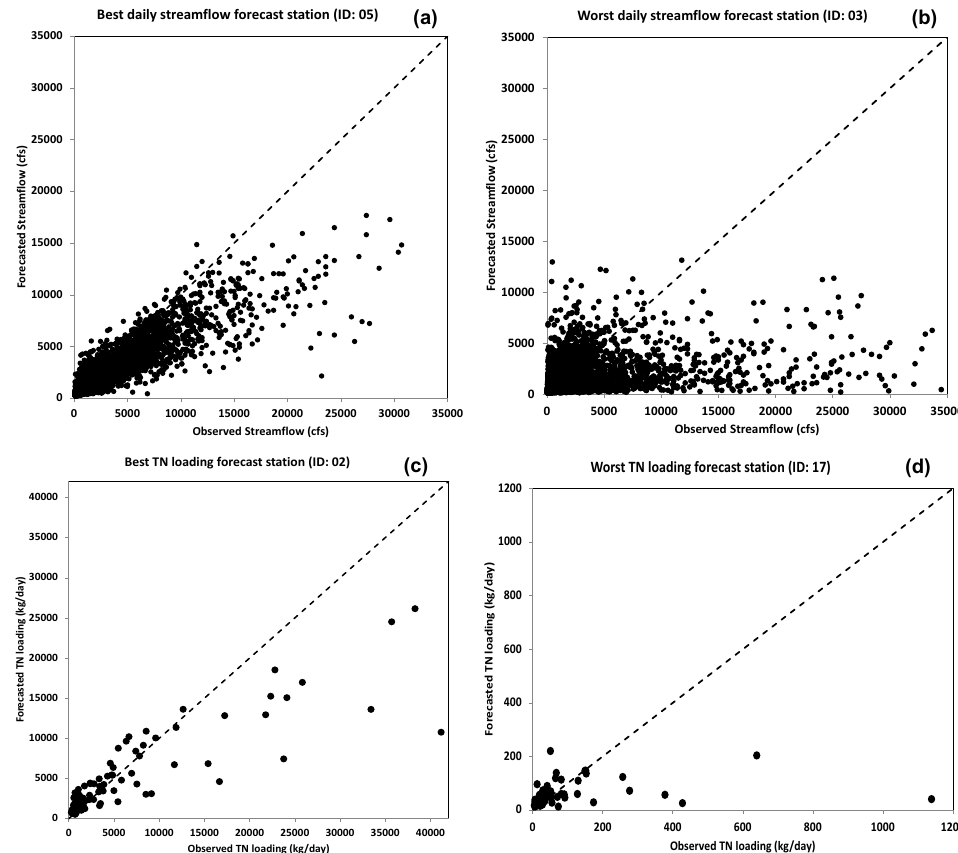
Figure 7. Comparison of observations and forecasts of streamflow ( a and b ) and TN loadings ( c and d ) for the stations with best (Streamflow: Ogeechee River near Eden, GA, TN: Tar River at Tarboro, NC) and worst forecasting skill (Streamflow: Rocky River near Norwood, NC, TN: Cypress Creek near Janice, Figure 7: Comparison of observation and forecasts of streamflow (a and b) and TN loadings (c 62 and d) for the stations with best (Streamflow: Ogeechee river near Eden, GA, TN: Tar river at 63 Tarboro, NC) and worst forecasting skill (Streamflow: Rocky river near Norwood, NC, TN: 64 Cypress creek near Janice, MS) 65